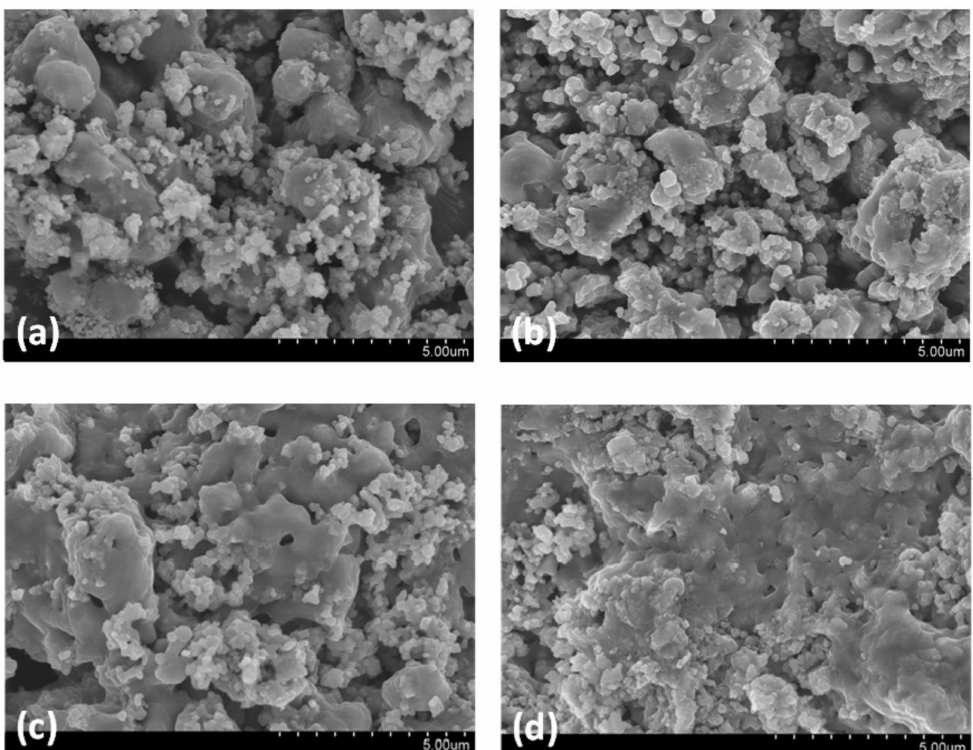
Figure 10. SEM images of CaTi-3 after ( a ) 1 cycle, ( b ) 2 cycle, ( c ) 3 cycle, and ( d ) 20 cycle experiments. The different types of behavior of the CaTi-3 sorbent cyclic experiment under N 2 flowing at low temperatures (700 ◦ C for 30 min, mild condition) or under CO 2 flowing at high temperatures (920 ◦ C for 15 min, severe condition) may be related to calcium formation on the support surface based on the XRD results of sorbents collected after cyclic experiment (Figure 11). Under mild regeneration conditions, the cyclic experiment process mainly involves Ca(OH) 2 and CaCO 3 species transformation. Ca(OH) 2 is under the molten state (melting point ~512 ◦ C), while CaCO 3 is in the solid state (melting point ~825 ◦ C) during carbonation and regeneration. During carbonation, the ions diffuse in molten Ca(OH) 2 layers more efficiently; thus, almost all calcium species can be utilized. When CaCO 3 forms, it will precipitate due to its larger density (2.71 cm 3 /g) than Ca(OH) 2 (2.21 cm 3 /g). During regeneration, the molten Ca(OH) 2 layer permits the easy regeneration of CaCO 3 located in the interior position. Therefore, nearly no capture capacity decay occurs. Under severe regeneration conditions, the cyclic experiment process mainly involves CaO and CaCO 3 species transformation. CaCO 3 is in the solid state during carbonation and under the molten state during regeneration; furthermore, CaO is in the solid state, and sintering cannot occur during carbonation and regeneration (melting point ~2613 ◦ C, Tammann temperature ~1154 ◦ C) [29]. During carbonation, external CaO can react with CO 2 to form CaCO 3 , whereas CO 32 − and O 2 − exchange occurs at the internal CaCO 3 /CaO interface [4]. During regeneration, CaO forms and precipitates in molten CaCO 3 (density of CaO is 3.34 cm 3 /g). The microstructure stacked by these aggregated precipitates will affect subsequent cycle carbonation reaction performance. More precipitants with densely stacked structures reduce the carbonation